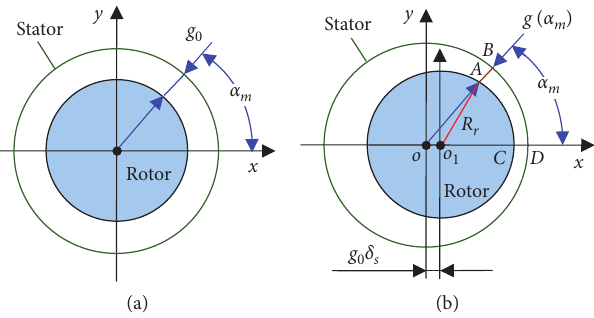
Figure 2: Air gap of generator: (a) normal; (b) radial